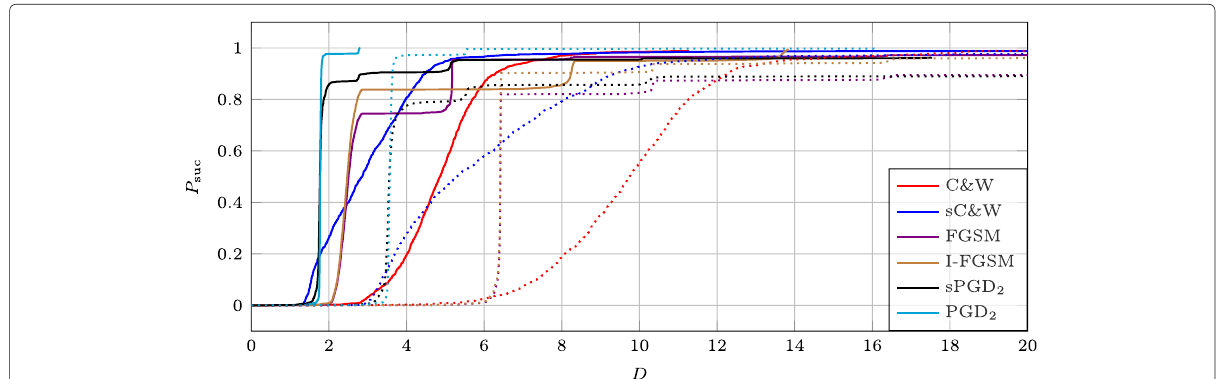
Fig. 6 Operating characteristics over ImageNet attacking InceptionV3 (solid lines) and ResNetV2-50 (dotted